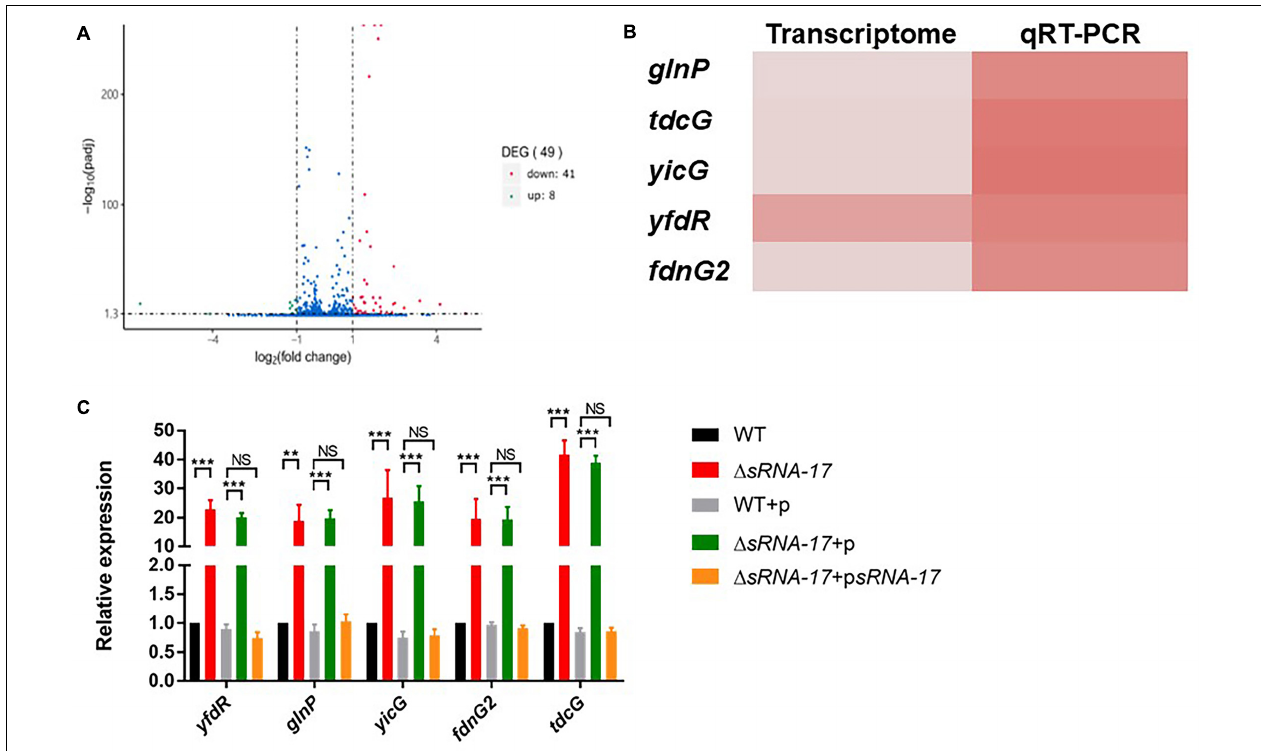
FIGURE 5 | Transcriptome analysis reveals differentially expressed genes regulated by sRNA-17. (A) Volcano plot shows the fold change of genes (log2 scale) between (cid:49) sRNA-17 strain and wild-type Rs218 strain in Luria–Bertani (LB) medium. Green dots, downregulated genes (fold change < 0.5); red dots, upregulated genes (fold change > 2). See Table 1 and Supplementary Table S3 for upregulated and downregulated gene lists, respectively. Adjusted P values were determined by DEGseq (Wang et al., 2010) based on Benjamini–Hochberg method. (B) Heatmap comparison of transcriptome and qRT-PCR analyses of upregulated genes in (cid:49) sRNA-17 strain compared with wild-type Rs218 strain. (C) Bar plot of qRT-PCR analyses of upregulated genes in the wild-type, (cid:49) sRNA-17 , and complementation strains. ** P < 0.01; *** P < 0.001; NS, no significance, P >